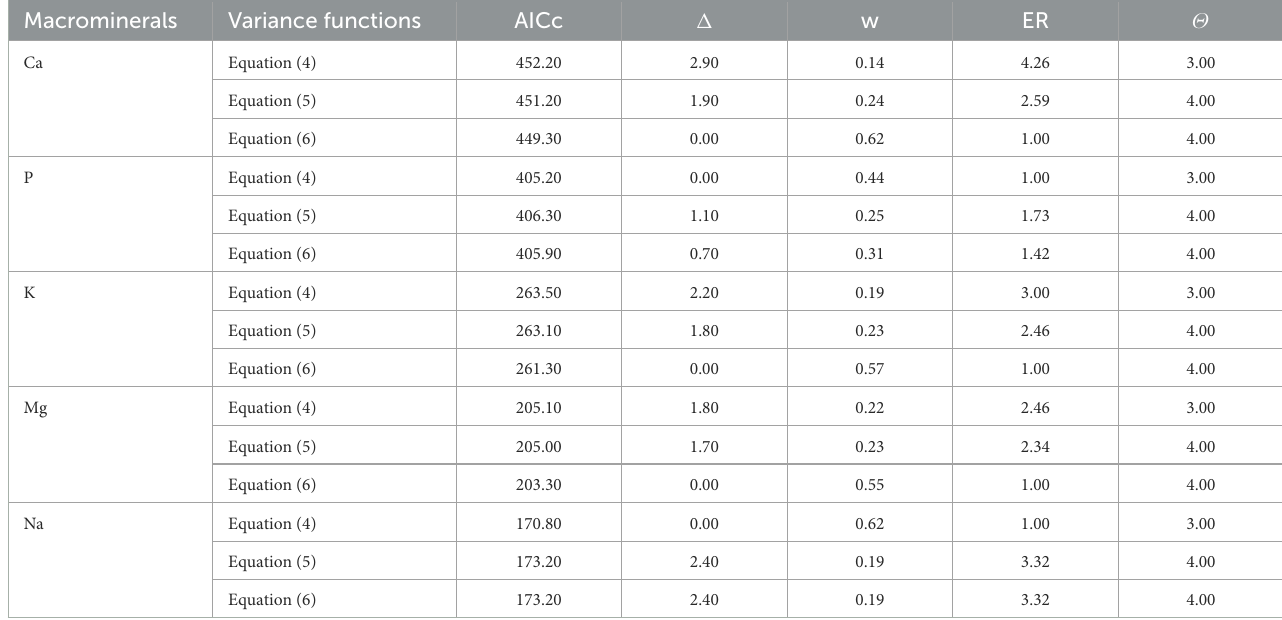
TABLE 7 Information criteria of fitted models to estimate the net requirements for maintenance of hair sheep.